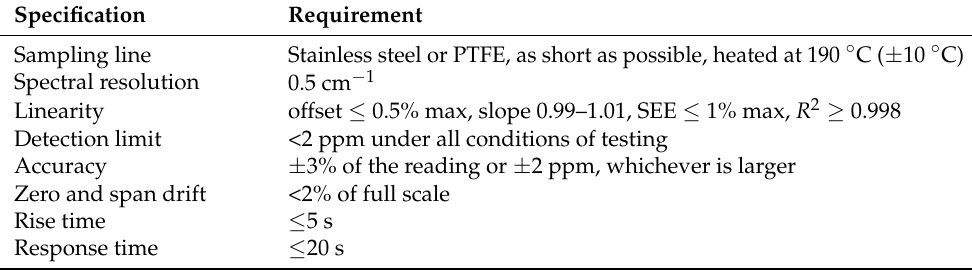
Table 3. Example of technical requirements for FTIR for NH 3 measurements in UNECE Reg.